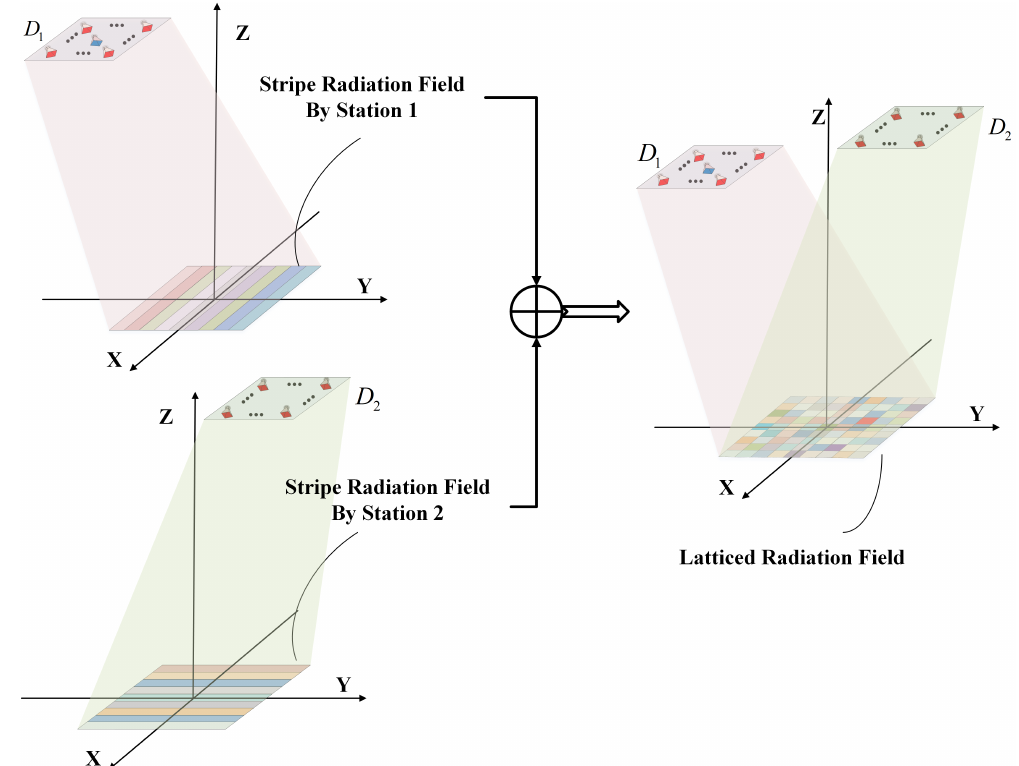
Figure 4. The superposition of the radiation field of bi-static